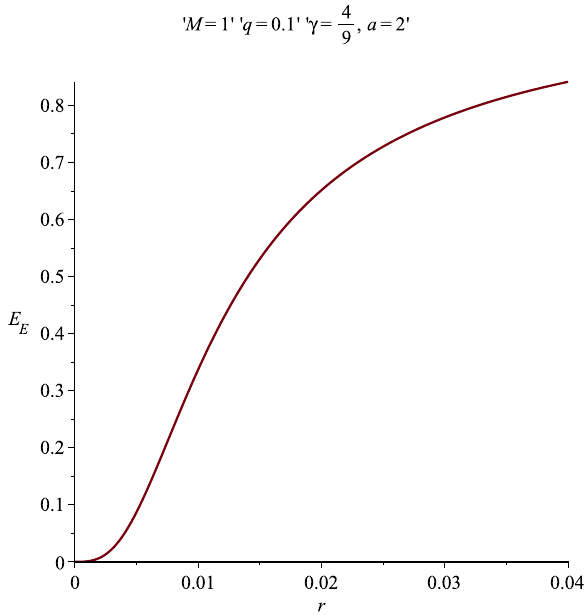
Figure 2. Einstein energy versus the radial distance r near the